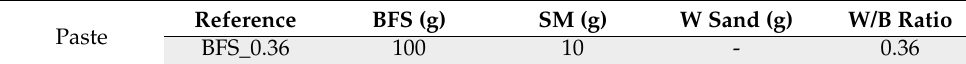
Table 1. Compositions of the prepared reference samples (paste).